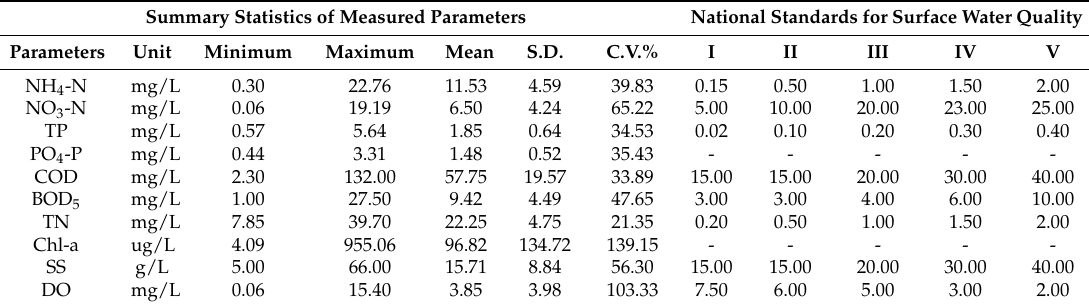
Table 1. Statistics of measured parameters and the national standards for surface water quality.